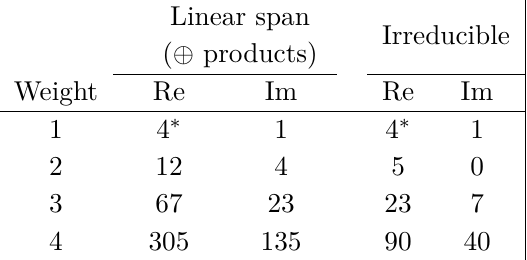
Table 3. Number of independent transcendental constants at each weight. The second column shows the dimensions of the linear spans of constants together with (weight-graded) products of lower-weight constants. The third columns shows the number of irreducible constants. weight